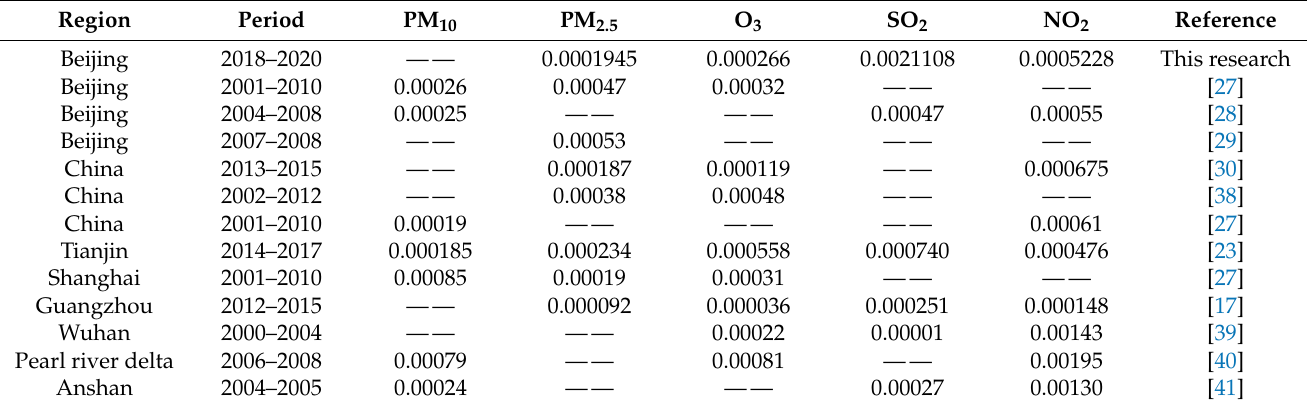
Table 6. Summary of studies on β coefficient of exposure–response relationship of pollutants.